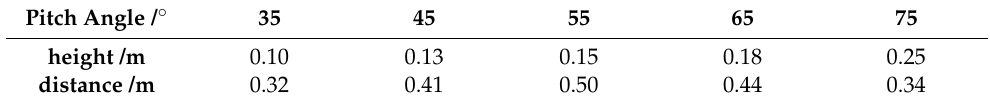
Table 6. Relationship between pitch angle and jump height and distance.